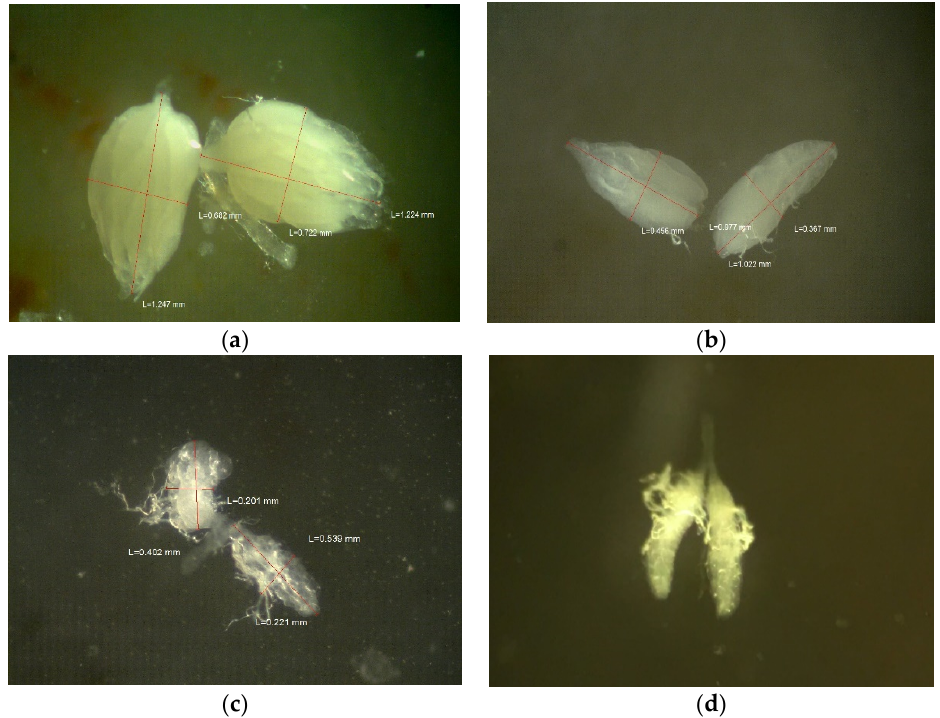
Figure 5. Ovary dissections of females exposed within 2 h of eclosion for 7 days to ( a ) organic control medium, ( b ) Roundup ® Super Concentrate at 2 g/L of glyphosate, ( c ) Roundup ® Ready to Use at 2 g/L of glyphosate, and ( d ) Roundup ® Super Concentrate at 10 g/L of glyphosate. Toxics 2021 , 9 , x FOR PEER REVIEW 3.2.2. H1-B: Roundup ® Interferes with Reproduction by Reducing the Number of Mature Oocytes